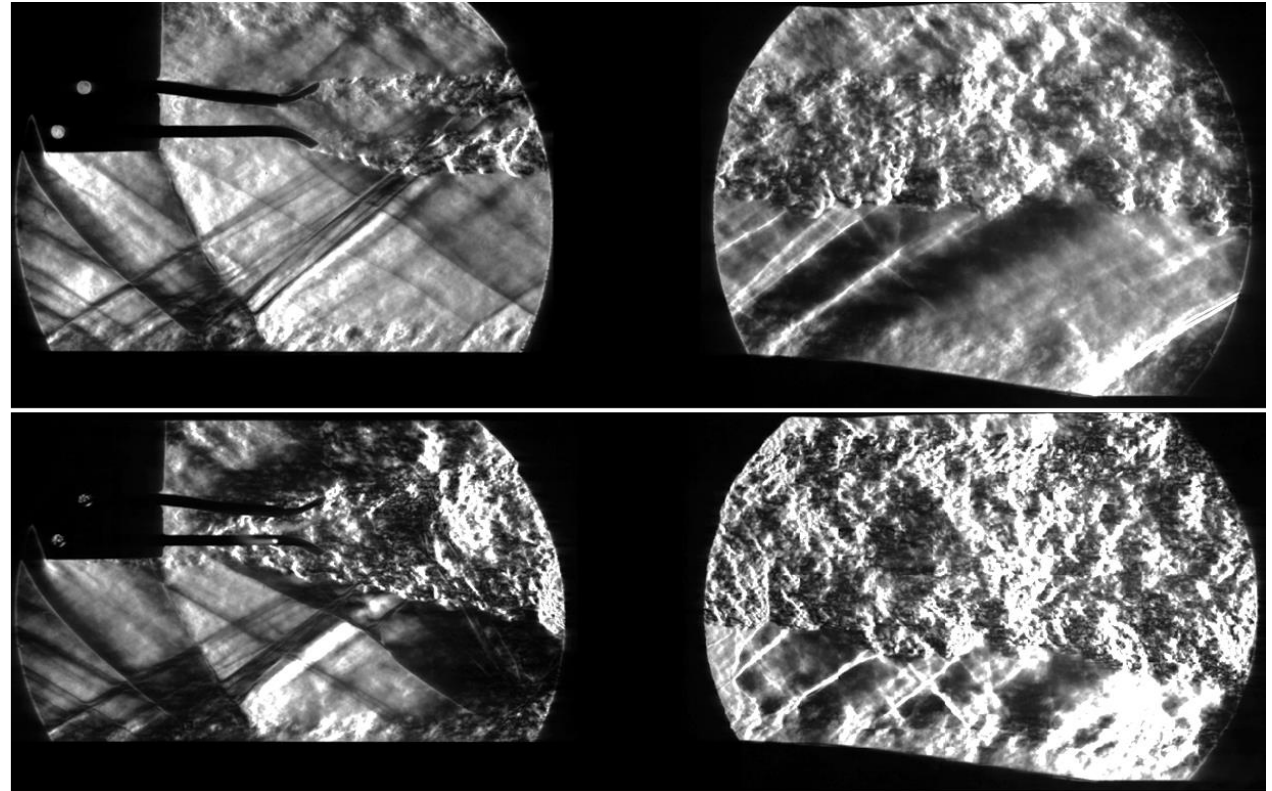
Figure 9. Schlieren visualization of the flow during the operation of the discharge ( top ) and during plasma-assisted combustion ( bottom ).